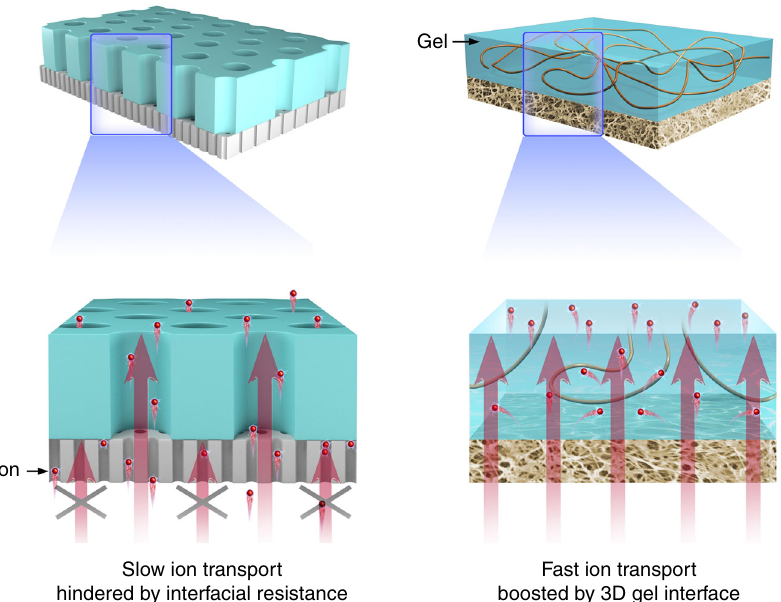
Fig. 1 Three-dimensional hydrogel interface with high transport ef fi ciency. The conventional heterogeneous membrane suffers from low interfacial ion transport ef fi ciency caused by mismatch of pore alignment and insuf fi cient coupling between channels of different dimensions. Polyelectrolyte hydrogel- based heterogeneous membrane featuring 3D gel interface with high ion transport ef fi ciency can substantially boost the osmotic energy